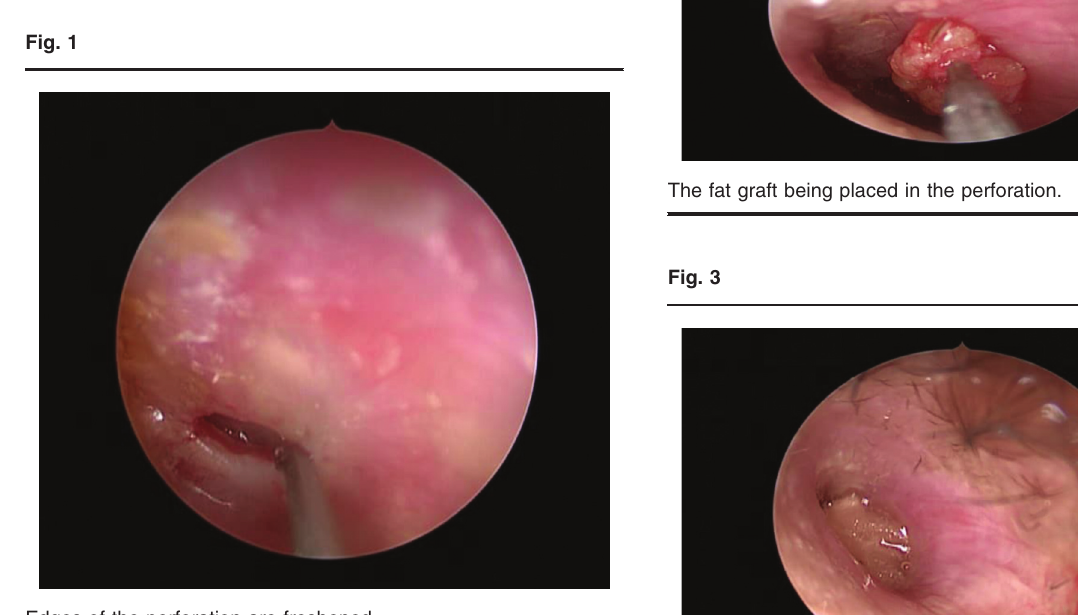
Edges of the perforation are freshened.